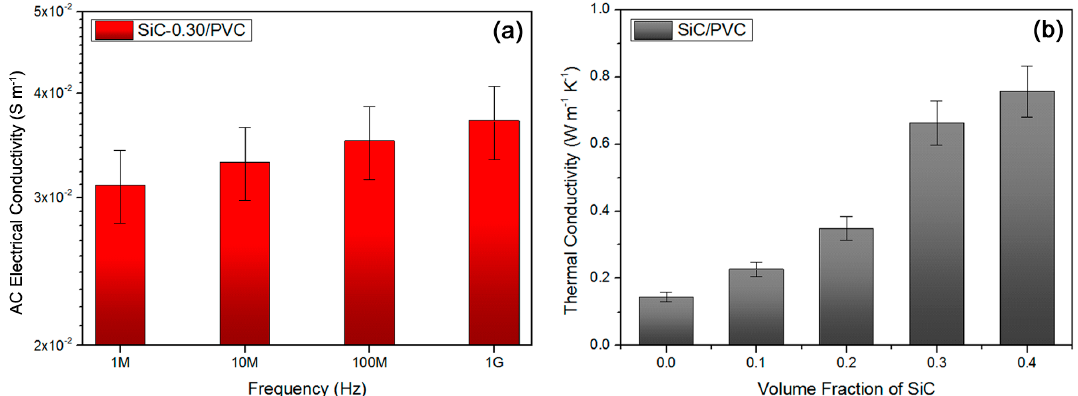
Figure 6. ( a ) Permittivity results showed low dependence of permittivity of SiC-0.30/PVC composite on high frequency, and ( b ) dielectric loss data verified low dependence of loss of that composite on high frequency.